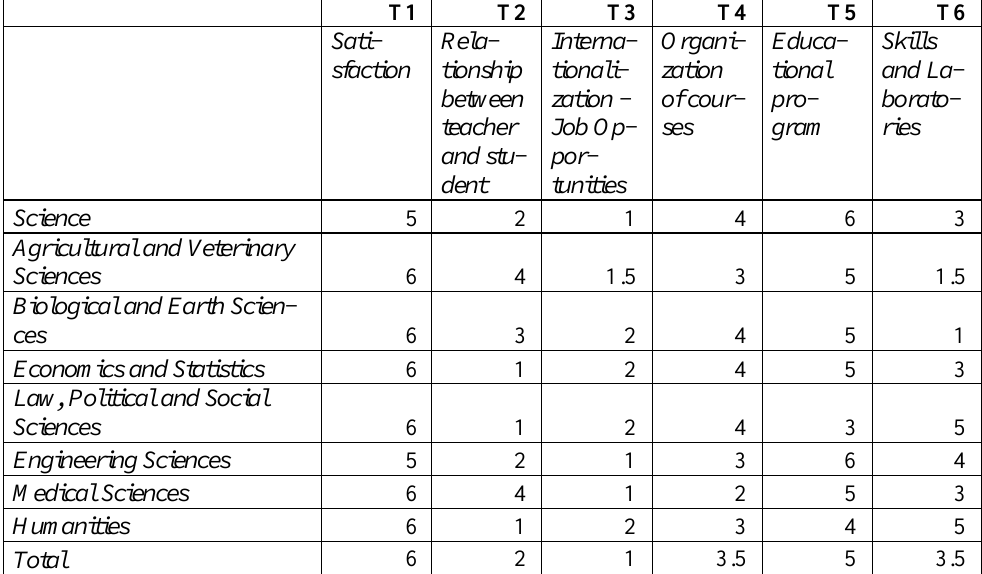
Ranking of percentages of themes by